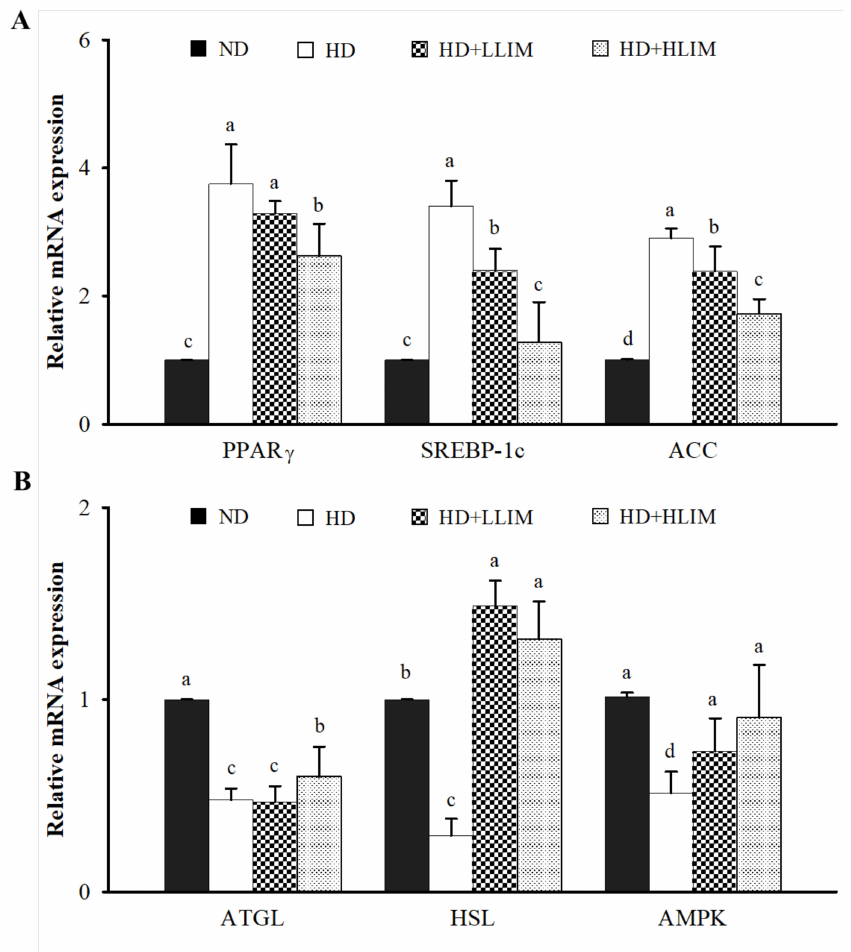
Figure 6. Effect of limonene (LIM) on mRNA expression of triglyceride metabolism in epididymal adipose tissue of high-calorie diet-induced obese rats. The expression levels of mRNA are related to ( A ) lipogenesis and ( B ) lipolysis. The mRNA expressions of PPAR γ , ACC, ATGL, HSL, and AMPK were determined by qPCR. Data were the means ± SD ( n = 6). The significant difference was evaluated by Duncan’s test for mRNA expression. Different lowercase letters (a–d) indicate a significant difference among groups ( p < 0.05). The group names abbreviated are defined in Table 1 legend. Peroxisome proliferator-activated receptor γ (PPAR γ ); sterol regulatory element binding protein-1c (SREBP-1c); acetyl-CoA carboxylase (ACC); hormone-sensitive lipase (HSL); adipose triglyceride lipase (ATGL); AMP-activated protein kinase